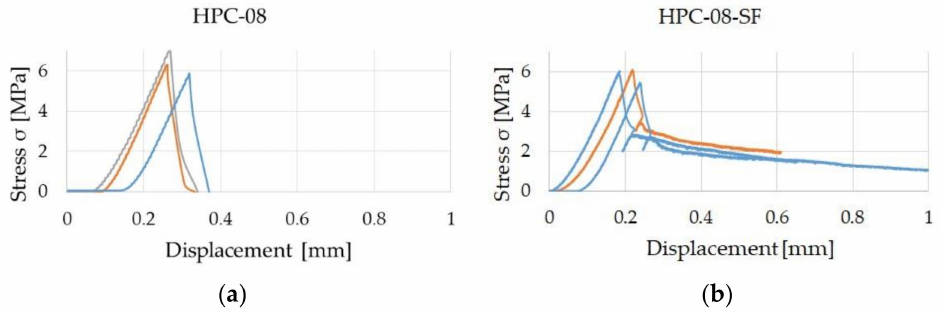
Figure 10. Stress-displacement diagrams. ( a ) HPC-08; ( b )